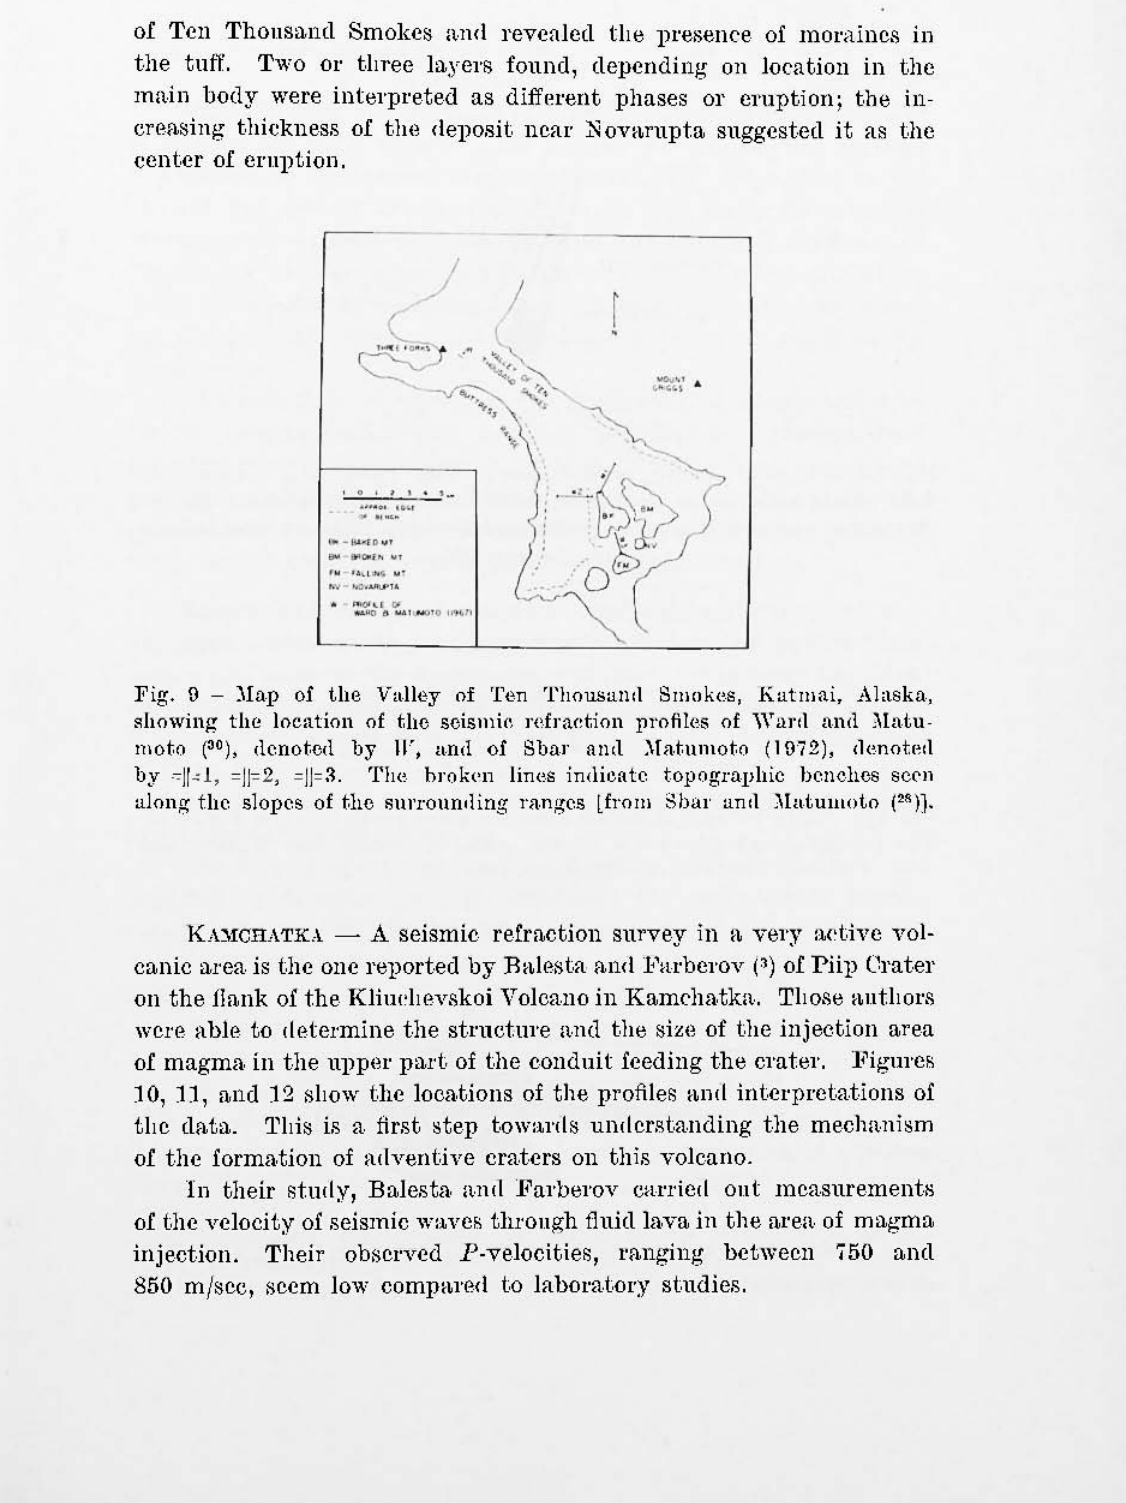
Fig. O - ~Iap 01 the Valley of Ten Thousallil Smokes, Katmai, Alaska, ~howing thc location of the seismil\ rdraetioll profìles of '\'anl and ~latu· moto (~O), denoted by W, und of Sbar allil ~ratumoto (1072), Ilenotell by ·-oll·d, =11=2, =11=3. The hrokl'l1 lines indioate topographie belloltcs